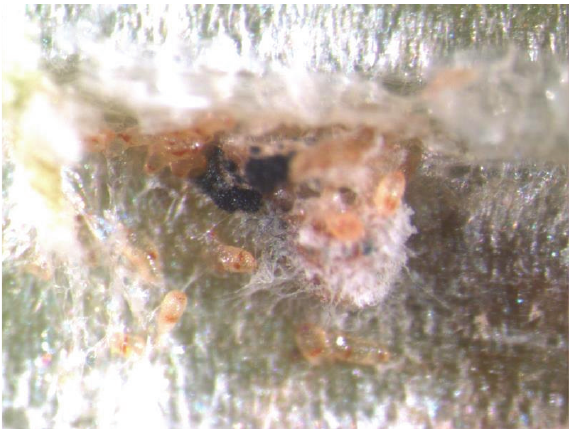
Figure 1: First instars with a mass of black yeasty mycelium (center) at approximately ten days after oviposition. White hyphae are extending out from the old egg clutch into the plant